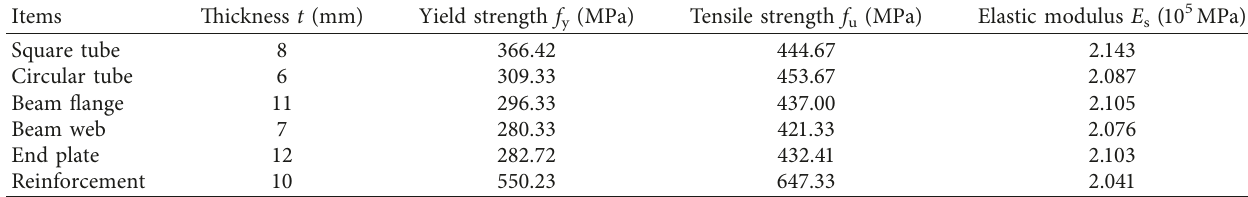
Table 2: Material properties of the steel components.